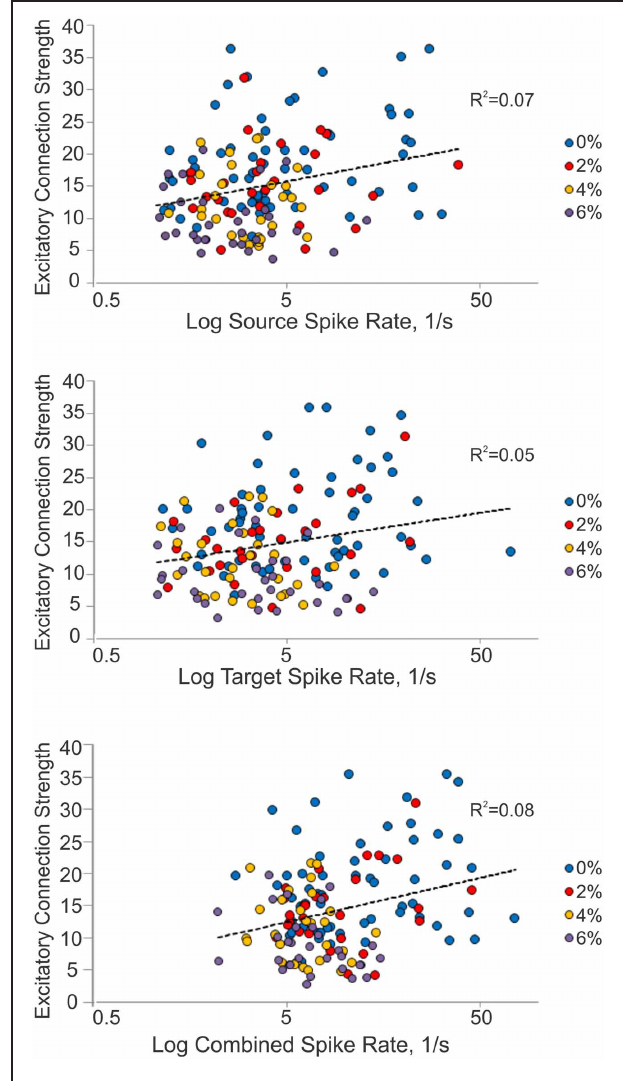
FIGURE 4 | Relationship between connection strength and spike rate. Scatterplot of excitatory connection strength and source (top), target (middle) and combined (bottom) spike rates from all experiments. Source spike rate ( R 2 = 0 . 07), target spike rate ( R 2 = 0 . 05), or combined spike rate ( R 2 = 0 . 08) is not an indicator of connection